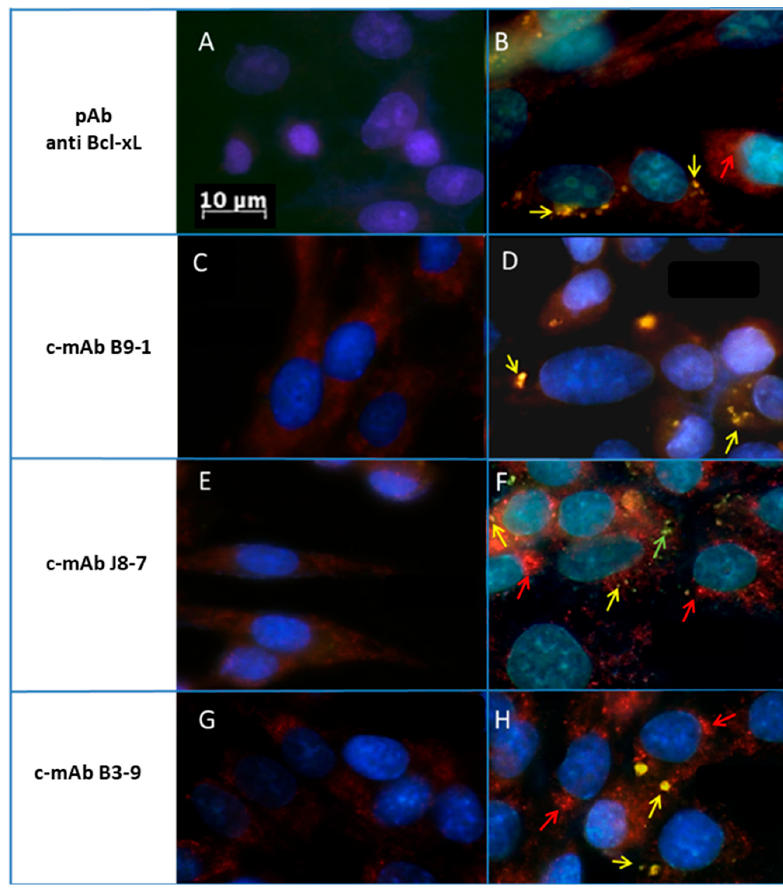
Figure 5. Cellular Bcl-xL detection by immunohistochemistry in SH-SY5Y culture chemically stressed with iron, using commercial polyclonal Bcl-xL antibodies ( A – B ) and c-mAb ( C – H ) (visualized at 594 nm, red color) and Thioflavin-T (visualized at 488 nm, green color). Hoechst dye stained the nucleus (visualized at 405 nm, blue color). Pictures resulted from the merging of the three stains. Amyloid Bcl-xL aggregate appeared in yellow as indicated by the arrows. We can note that some aggregates appear in green, suggesting other protein types of amyloid deposits.